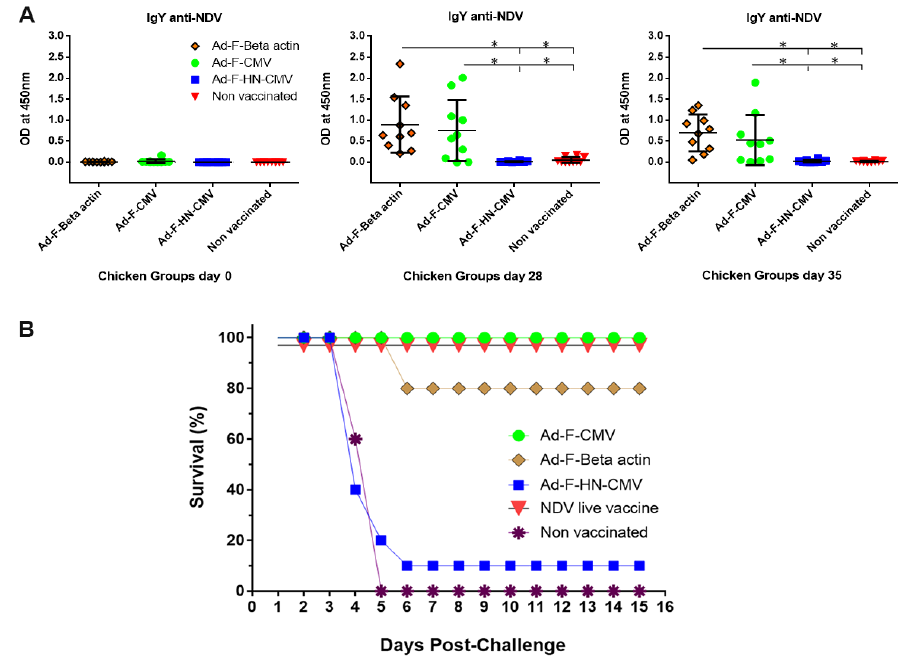
Figure 7. Analysis of the humoral immune response generated in chickens against NDV-encoded antigens and assessment of the protective efficacy: The level of anti-NDV antibodies after immunization with the recombinant adenoviral vectors Ad-F- β -actin, Ad-F-CMV, and Ad-F-HN- CMV were evaluated by ELISA ( A ) for the detection of IgY-specific antibodies in the serum of chickens vaccinated via i.m. with two doses of 10 10 TCID 50 . Mean optical values were calculated from serum of individual animals. The figure shows the means ± standard deviations of optical density values representing the S/P ratio calculated as previously described. Specific antibodies were detected until the last determination, prior to the lethal challenge with NDV and were found to be over the S/P cutoff value of 0.3, one indicative of protective efficacy. Specific antibodies were not detected in the negative control groups. Statistically significant differences ( p < 0.05) are represented in the figure with an asterisk. ( B ) Eight weeks after the primary immunization, all chickens were intramuscularly challenged with 0.5 × 10 6.5 ELD 50 of the NDV isolate Debre/zeit/2018 (MN909678). A positive control group vaccinated with NDV live vaccine according to the manufacturer’s instructions as well as one group of non-vaccinated animals were included in the challenge. All chickens were monitored for 15 days to record the appearance of clinical signs of the disease and the total number of deaths. After this period, the percent survival was 100% for the groups vaccinated with the Ad-F-CMV and the NDV live vaccine, 80% for the group of chickens receiving the Ad-F- β actin vector, and 10% in the group vaccinated with the Ad-F-HN-CMV. One hundred percent of mortality and the typical signs of the disease were recorded in the group of non-immunized animals. 4. Discussion Newcastle Disease (ND) is a permanent threat that negatively impacts poultry producers worldwide despite the use of live-attenuated and inactivated vaccines [32]. The disease can affect over 236 species of birds [33] and remains one of the most critical diseases for poultry species, close to the impact of avian influenza [34]. In sub-Saharan Africa, ND outbreaks with high mortality have